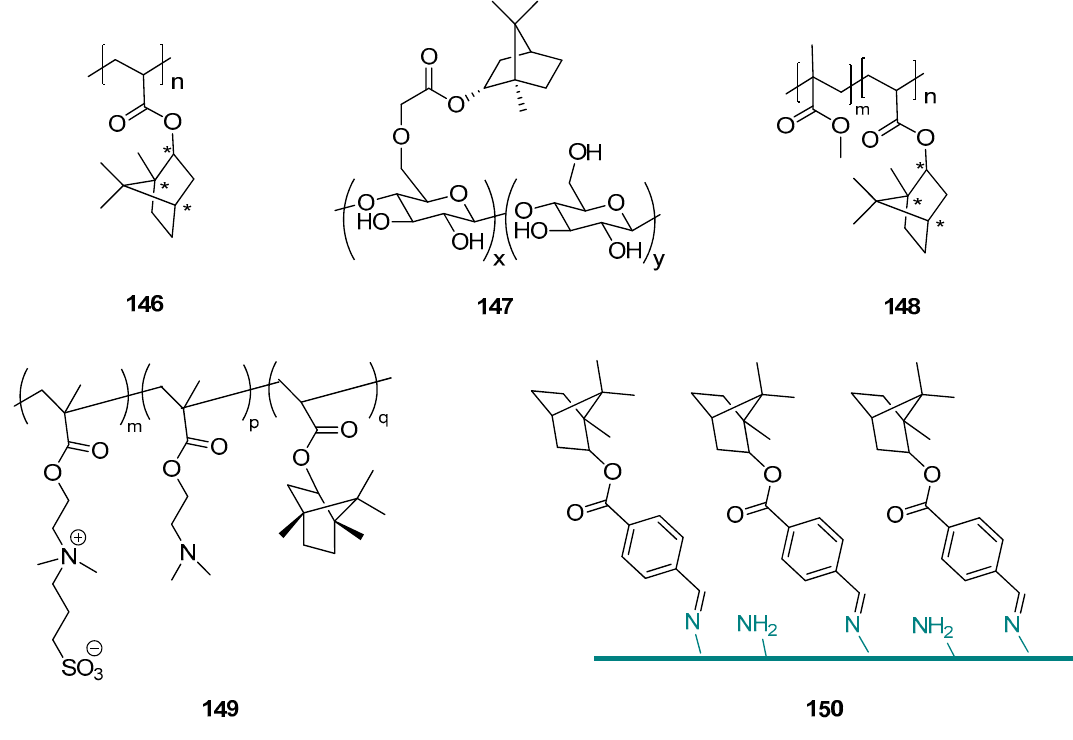
Figure 43. Borneol-based polymer.